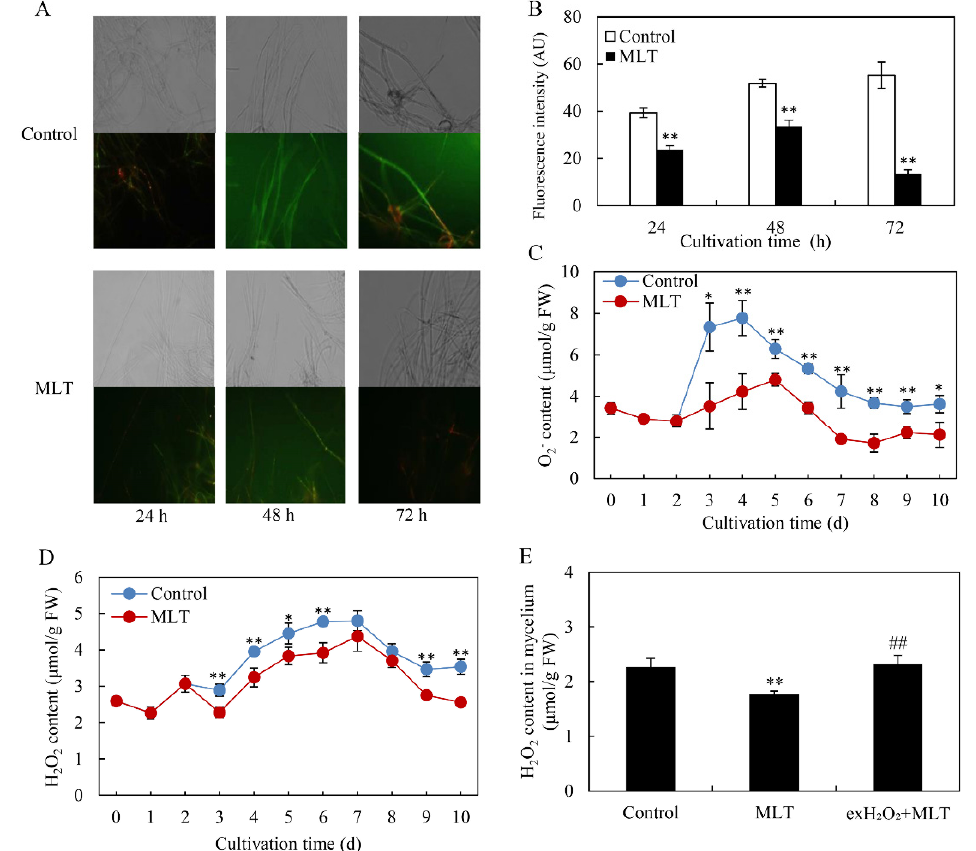
Figure 3. The effects of melatonin (MLT) on ROS production of Shiraia sp. S9 in liquid culture. ( A ) Bright-field image (above) and fluorescence microscopy of DCFH-DA-stained mycelia (below) (400 × ) in the cultures. The culture was maintained in a 150 mL flask containing 50 mL medium at 150 r/min and 28 °C under light/dark shift (24 h:24 h). MLT at 100 μ M was added on day 2 of the culture. ( B ) Fluorescence intensity of ROS stained by DCFH-DA after 100 μ M MLT treatment. Time course of O 2 − ( C ) and H 2 O 2 contents ( D ) in S9 mycelia. ( E ) H 2 O 2 content in mycelia after MLT treatment with exogenous H 2 O 2 for 24 h. H 2 O 2 (100 µ M) was added 30 min prior to MLT treatment. Values are mean ± SD from three independent experiments (* p < 0.05 and ** p < 0.01 vs. control, ## p < 0.01 vs. MLT treatment).